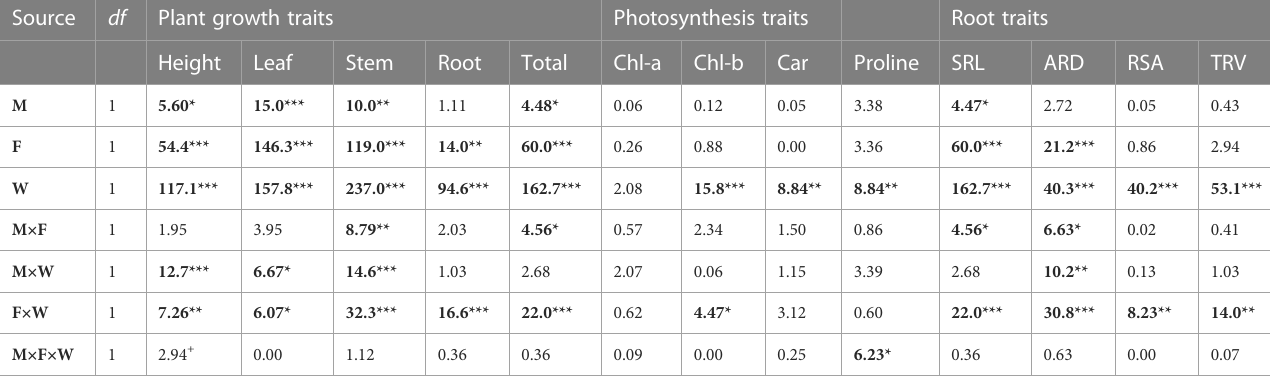
TABLE 1 Effects of fertilization (F), water addition (W) and inoculation with arbuscular mycorrhizal fungi (M) on plant height (repeated measures ANOVA) and on plant biomass, root traits and photosynthetic traits (General Linear Mixed Models, GLMM) of Artemisia ordosica plants grown in the greenhouse.